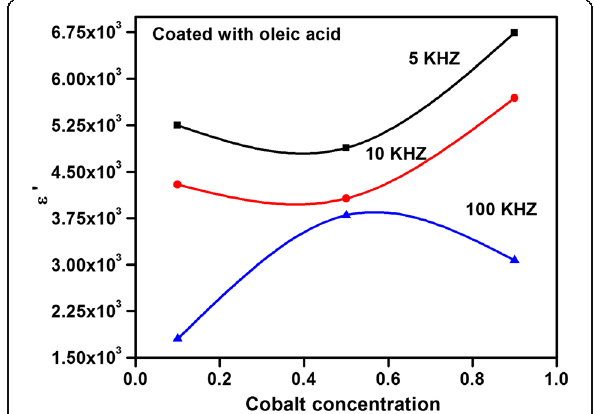
Fig. 5 Variation of dielectric constant with cobalt content at 5, 10